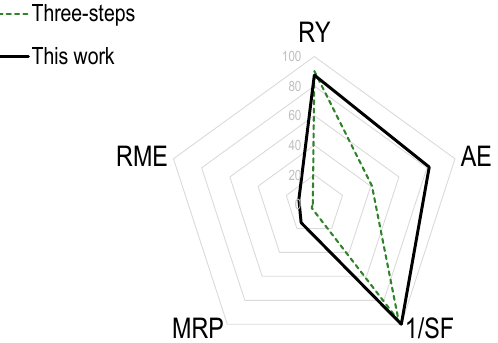
Figure 1. Radial-pentagon diagram with metrics (%): reaction yield (RY), atom economy (AE), reaction mass efficiency (RME), mass recovery parameter (MRP), and inverse of stoichiometric factor (1/SF). Comparison of both methodologies: multistep reaction [20], and one-step reaction in this work.